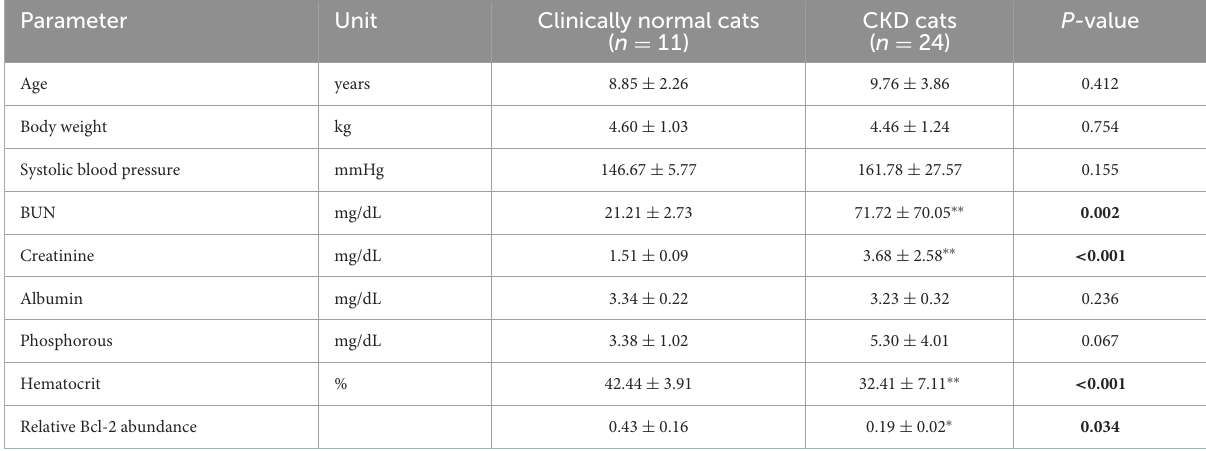
TABLE 1 Mean ± standard deviations (SDs) of other parameters and relative Bcl-2 abundance between clinically normal age-matched and chronic kidney disease